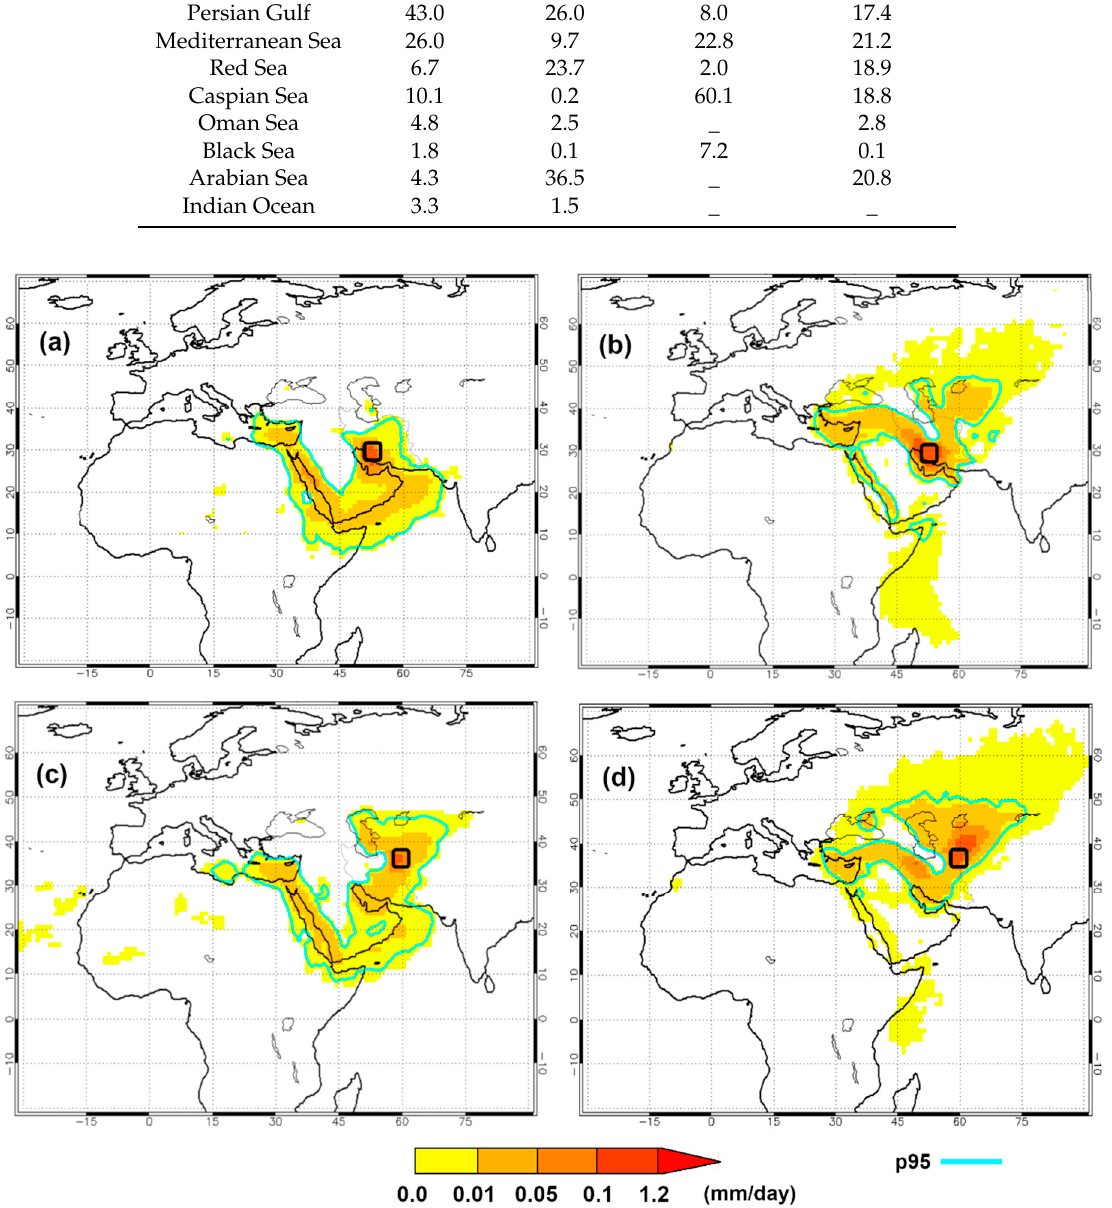
Figure 3. ( E − P ) > 0 values (mm/day) obtained in air masses tracked backward in time from Shiraz and Mashhad boxes during the wet (November to April) ( a , c ) and dry (May to October) ( b , d ) periods, respectively, from 1981 to 2015. The light blue line shows the boundaries of 95 percentiles of ( E − P ) > 0.